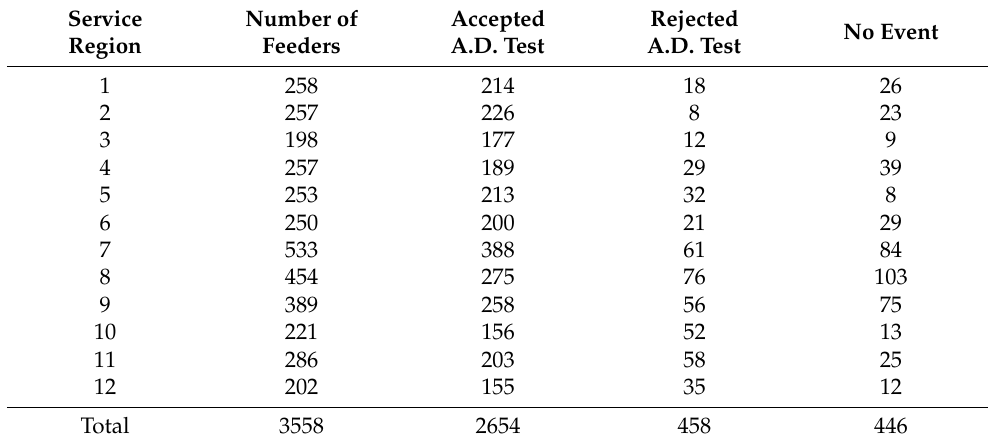
Table 2. Results of the Anderson–Darling test categorized by 12 service regions.